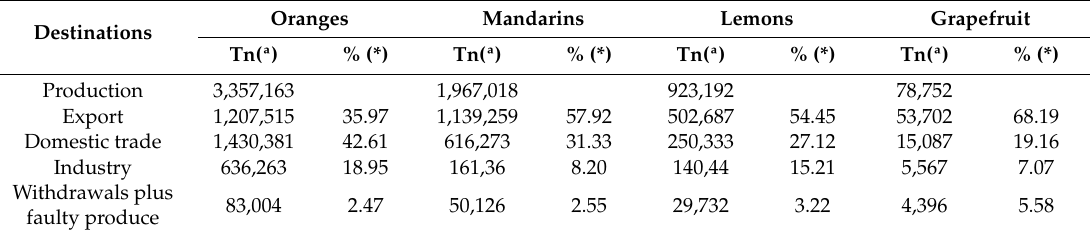
Table 1. Situation of citrus production and its destinations (2017 / 2018 season).